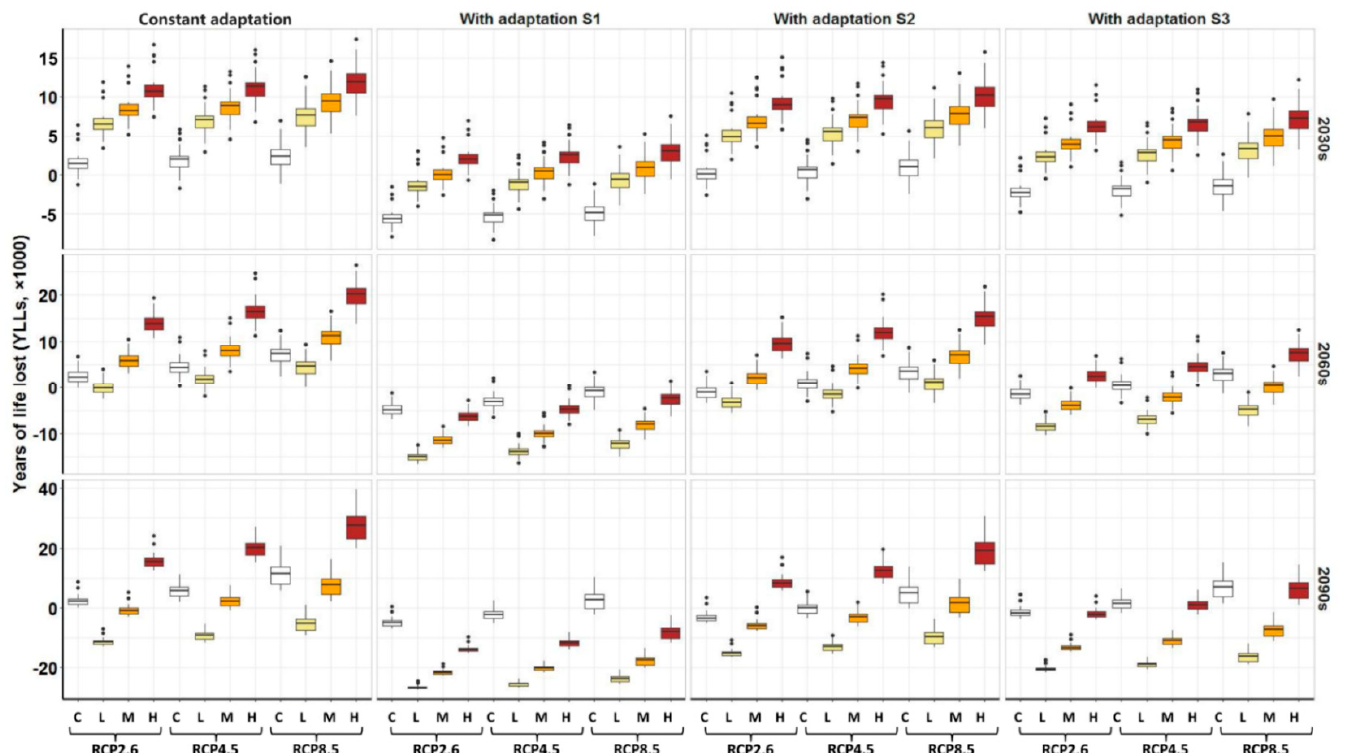
Figure 4. Impacts of population expansion and adaptation on the annual heat-related YLLs in the future. Constant adaptation: People’s adaptation to high temperature will remain constant at the 2010 level. Adaptation S1: People’s adaptation to high temperature will increase by 8.92% per decade. Adaptation S2: People’s adaptation to high temperature will increase by 4.60% per decade. Adaptation S3: People’s adaptation to high temperature will increase by 0.2 °C per decade. C: The population size will remain constant at the 2010 level. L: Low population expansion scenario. M: Medium population expansion scenario. H: High population expansion scenario. The three rows of panel show the effects of population expansion and adaptation on the heat-related YLLs in 2030s, 2060s, and 2090s, respectively. The heat-related YLLs in the future have been subtracted by the heat-related YLLs in the 1980s.